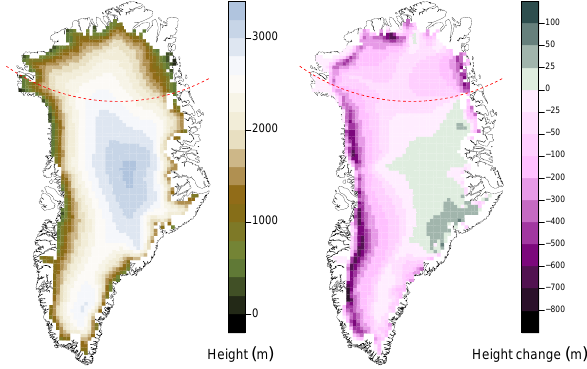
Fig.1. Left: icesheetsurfaceelevationinthecontrolexperiments. Right: elevationchangeintheNonUn Fig. 1. Left: ice sheet surface elevation in the control experiments. experiments(NonUn-control). Reddashedlineis77 ◦ N. figure Right: elevation change in the NonUn experiments (NonUn – con- trol). Red dashed line is 77 ◦ N.